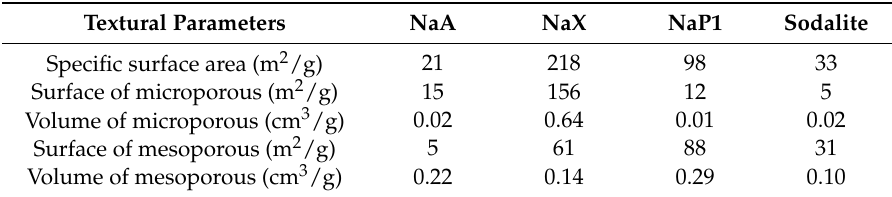
Table 5. Textural parameters of zeolite materials used in Table 5 Textural parameters of zeolite materials used in research.